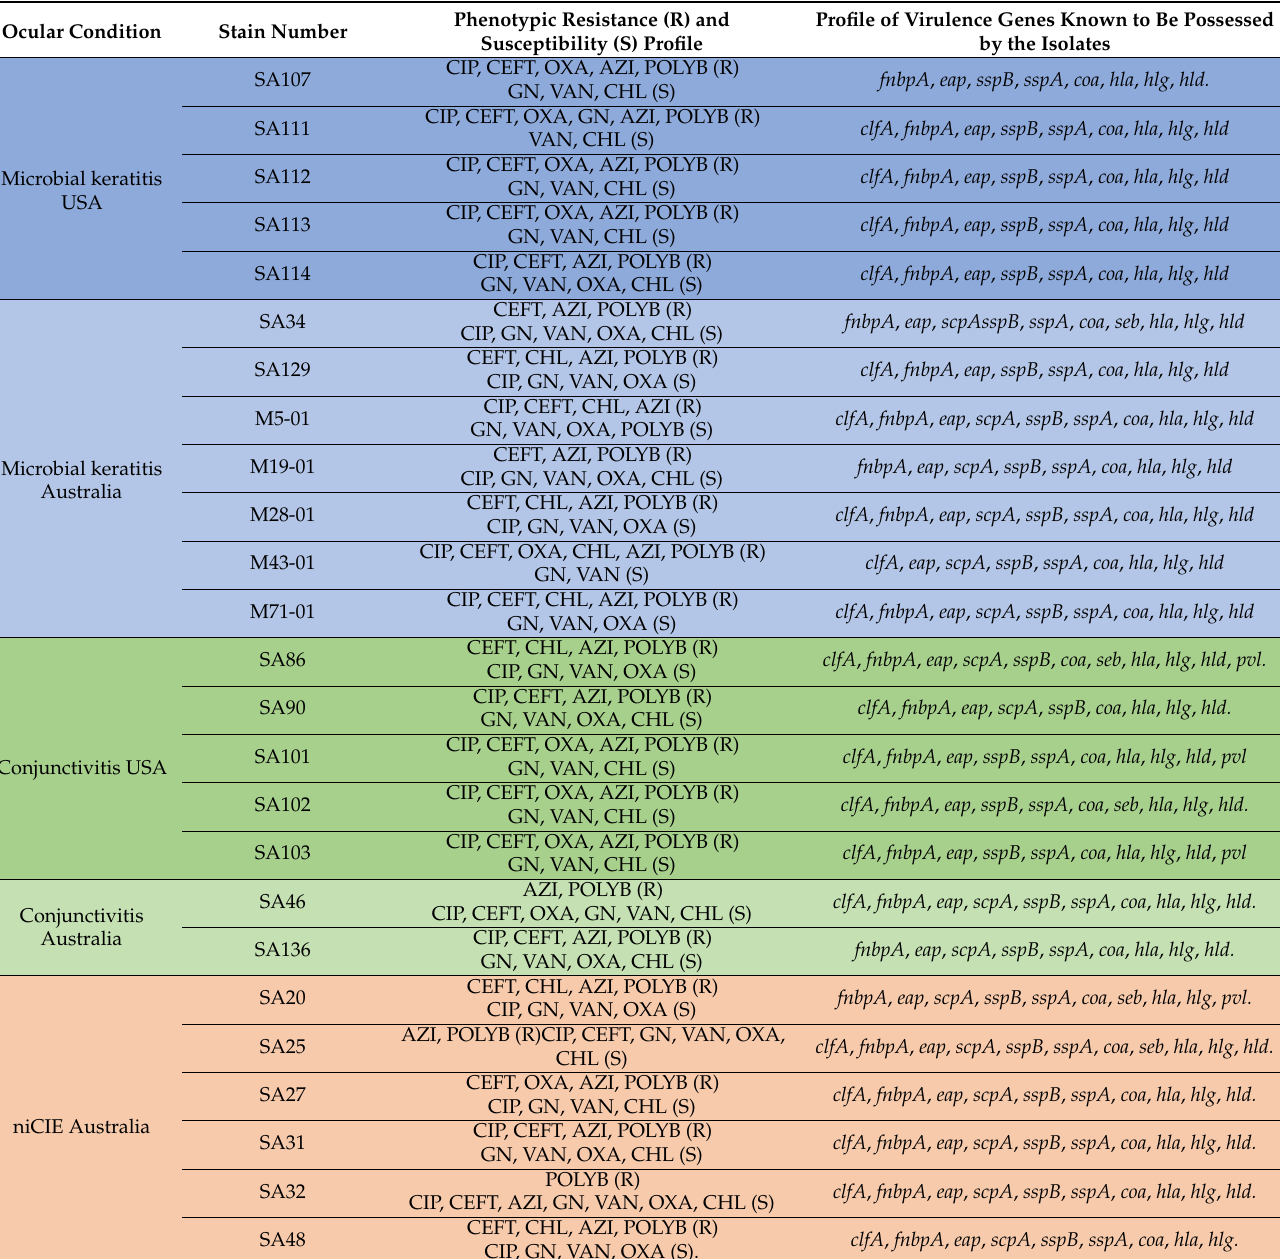
Table 4. Susceptibility and virulence profiles of S. aureus strains